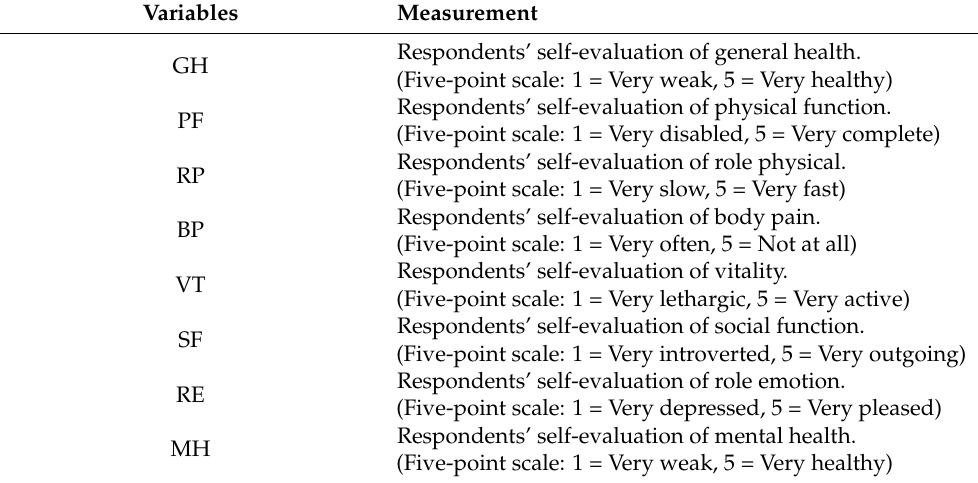
Table 2. Measurements of the dependent variable quality of life (QoL).